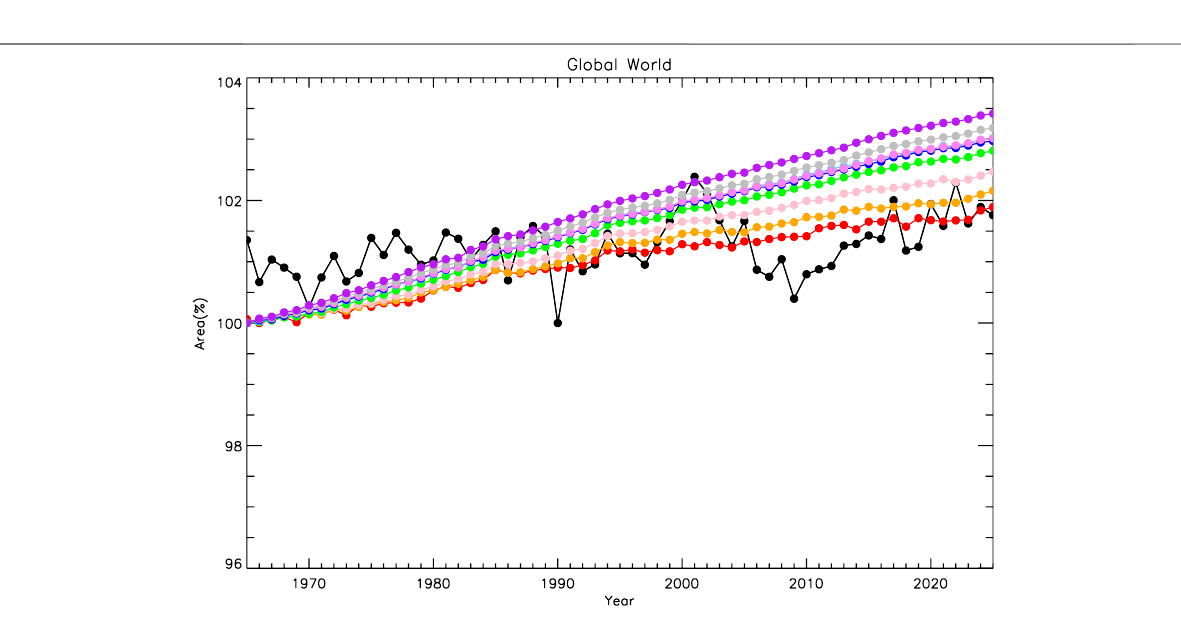
FIGURE 13 | Same as Figure 11 but for the global